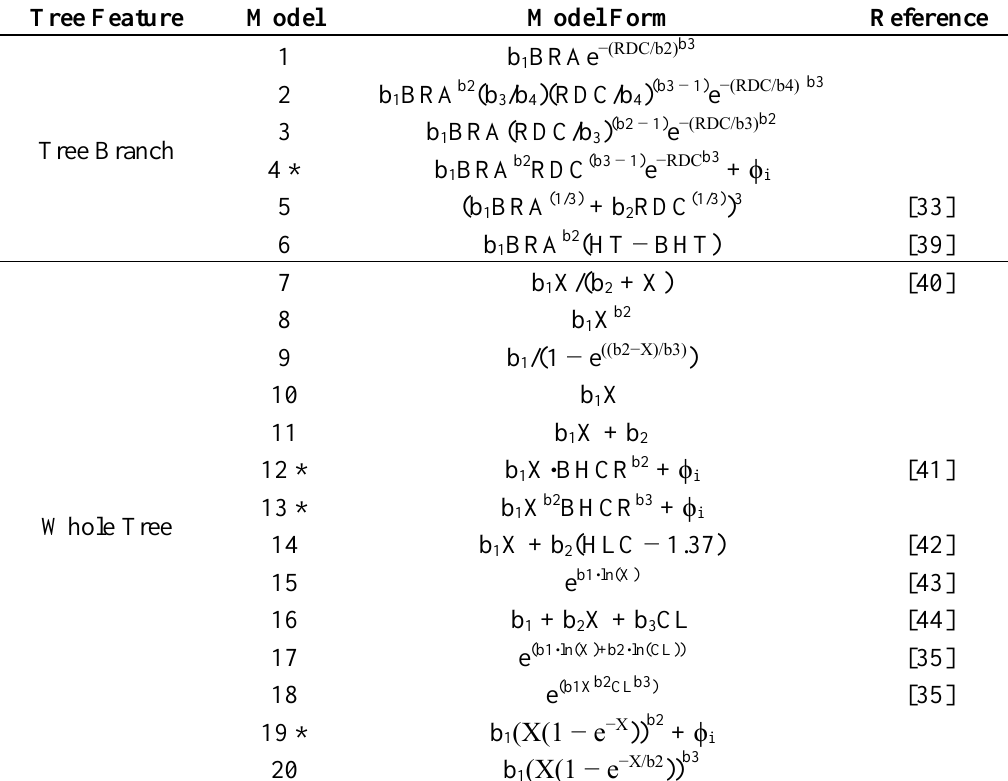
Table 3. Summary of candidate leaf area prediction models sorted by associated tree feature. References given for existing leaf area models taken from the